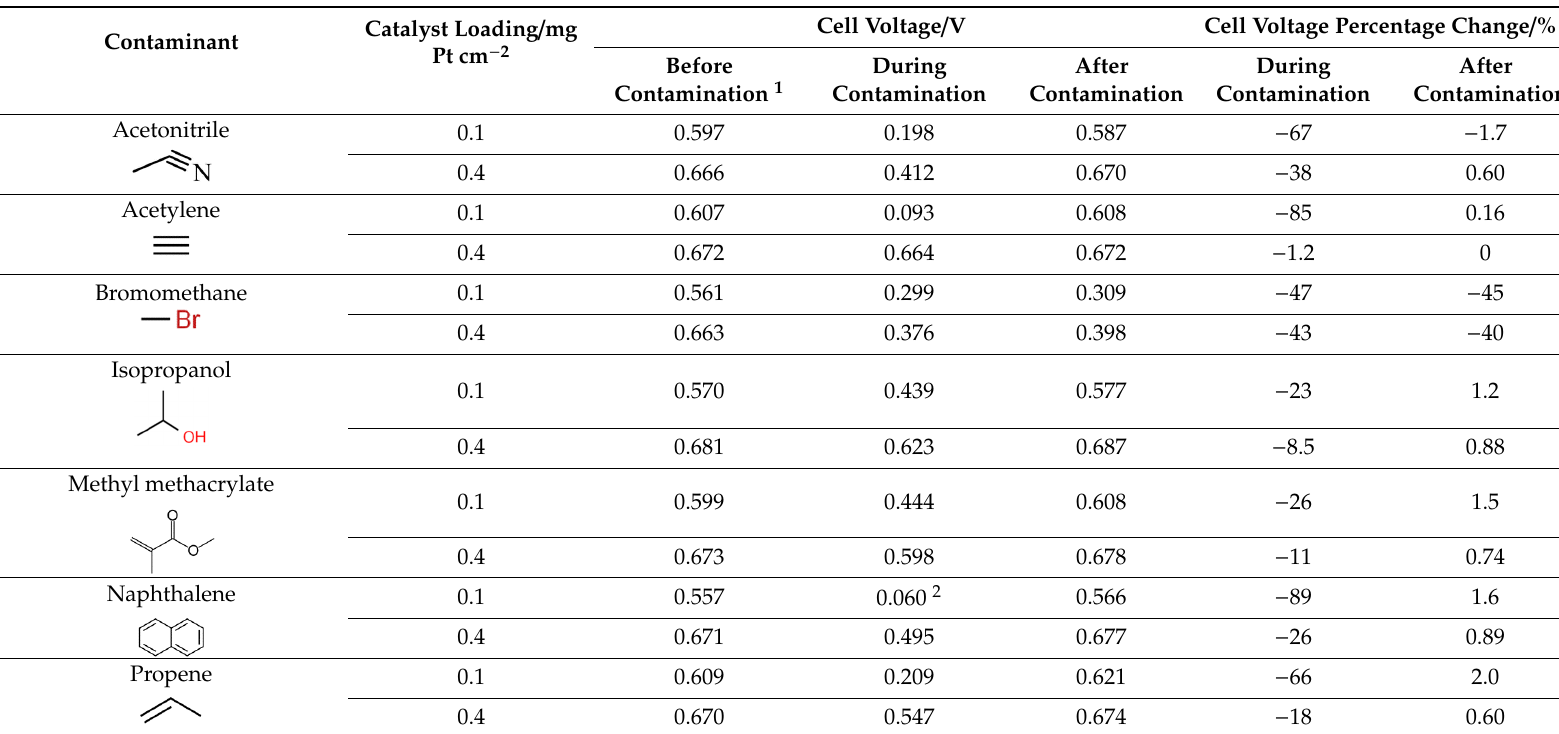
The magnitude of the cell voltage change during contamination (Table 1) with catalyst loading is species-dependent. For instance, the catalyst loading hardly affected the cell voltage loss for bromomethane ( − 43% and − 47%), whereas for acetylene, the cell voltage loss substantially increased from − 1.2% to − 85% with a catalyst loading decrease. This observation is attributed to different contamination mechanisms. Impedance spectroscopy data obtained during contamination by all Table 1 species and with a 0.4 mg Pt cm − 2 catalyst loading